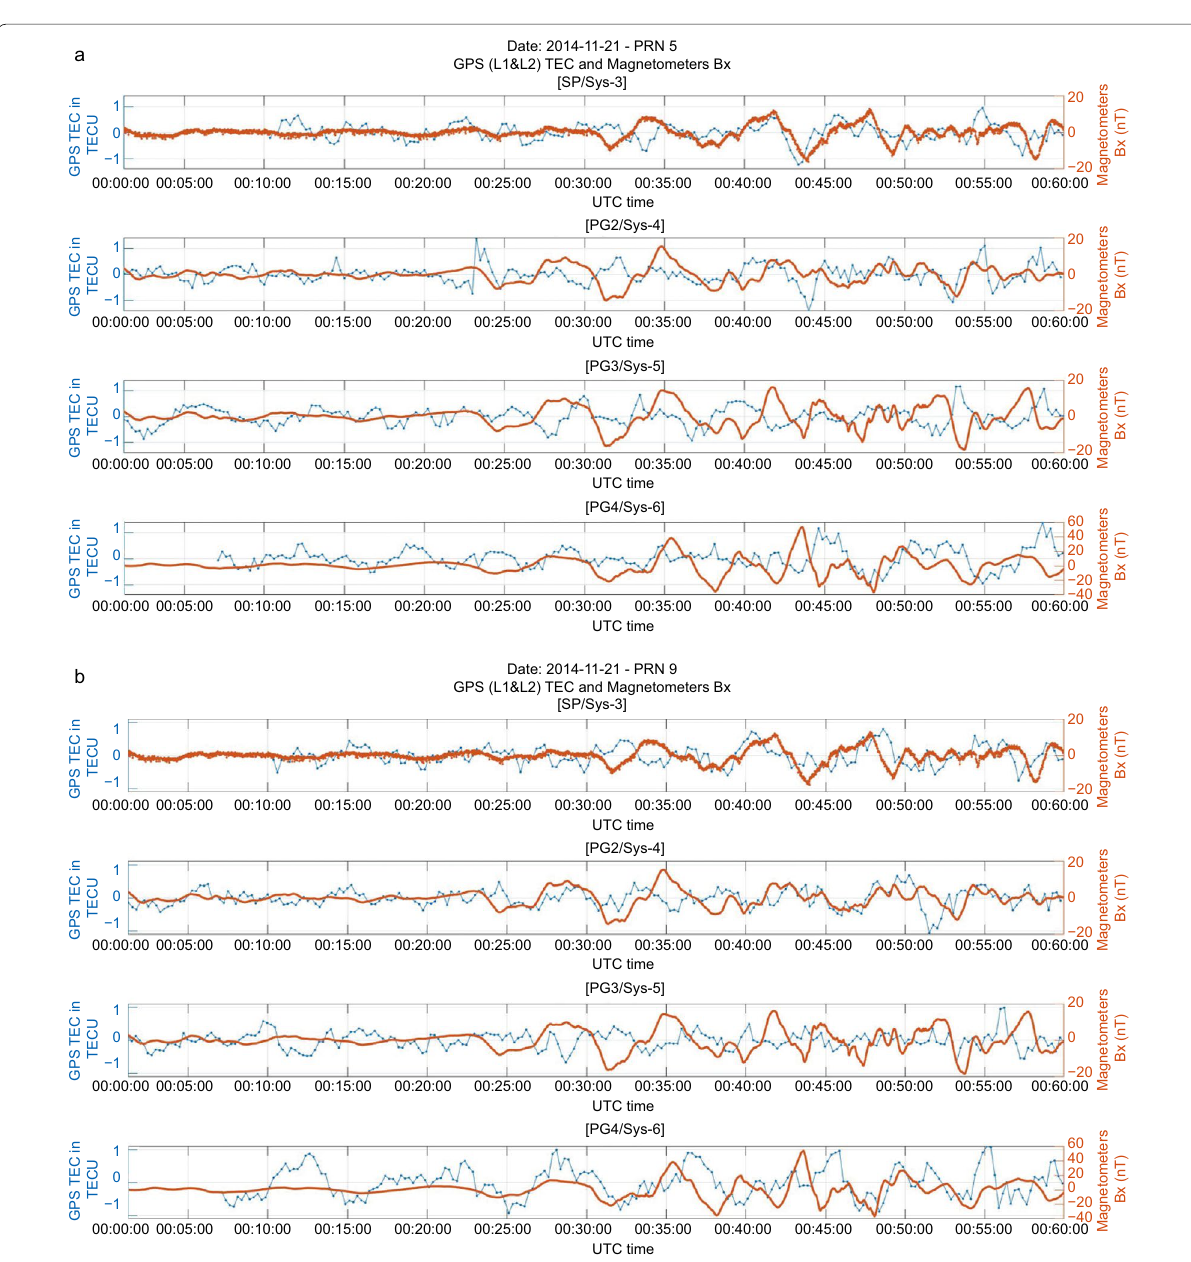
Fig. 5 GPS TEC and magnetic field superposition stack plots from multiple PG stations a PRN 5 b PRN 9. Adapted from Scales et al.